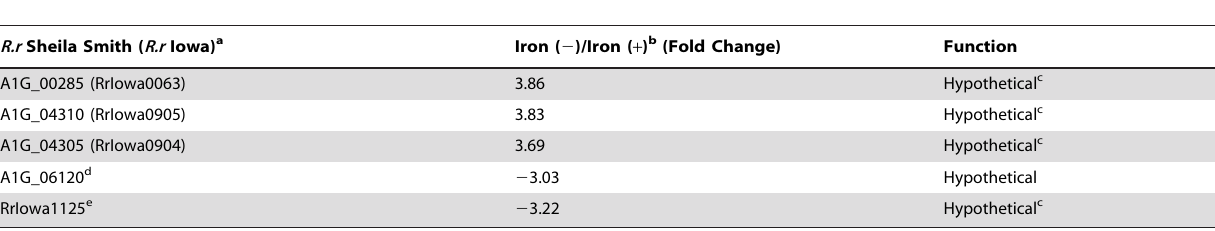
a locus_tags for R. rickettsii Sheila Smith (CP000848) and Iowa (CP000766). b Comparison of gene expression levels from R. rickettsii grown for three days at 34 u C and then incubated with 200 m M of deferozamine mesylate for 24 hrs to R. rickettsii grown for three days at 34 u C. c Gene fragment or predicted gene less than 10 Kda. d